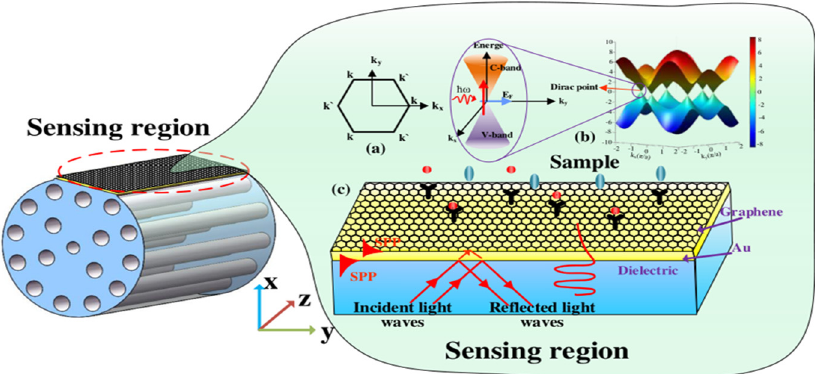
Figure 3. SPR-sensing mechanism of D-type photonic crystal fiber (PCF) sensor. ( a ) Graphene Bril- louin zone. ( b ) Linear dispersion diagram of the band structure of monolayer graphene. ( c ) Schematic diagram of graphene-Au-sensing mechanism. Reproduced from [81] with permission of the Multidisciplinary Digital Publishing Institute.